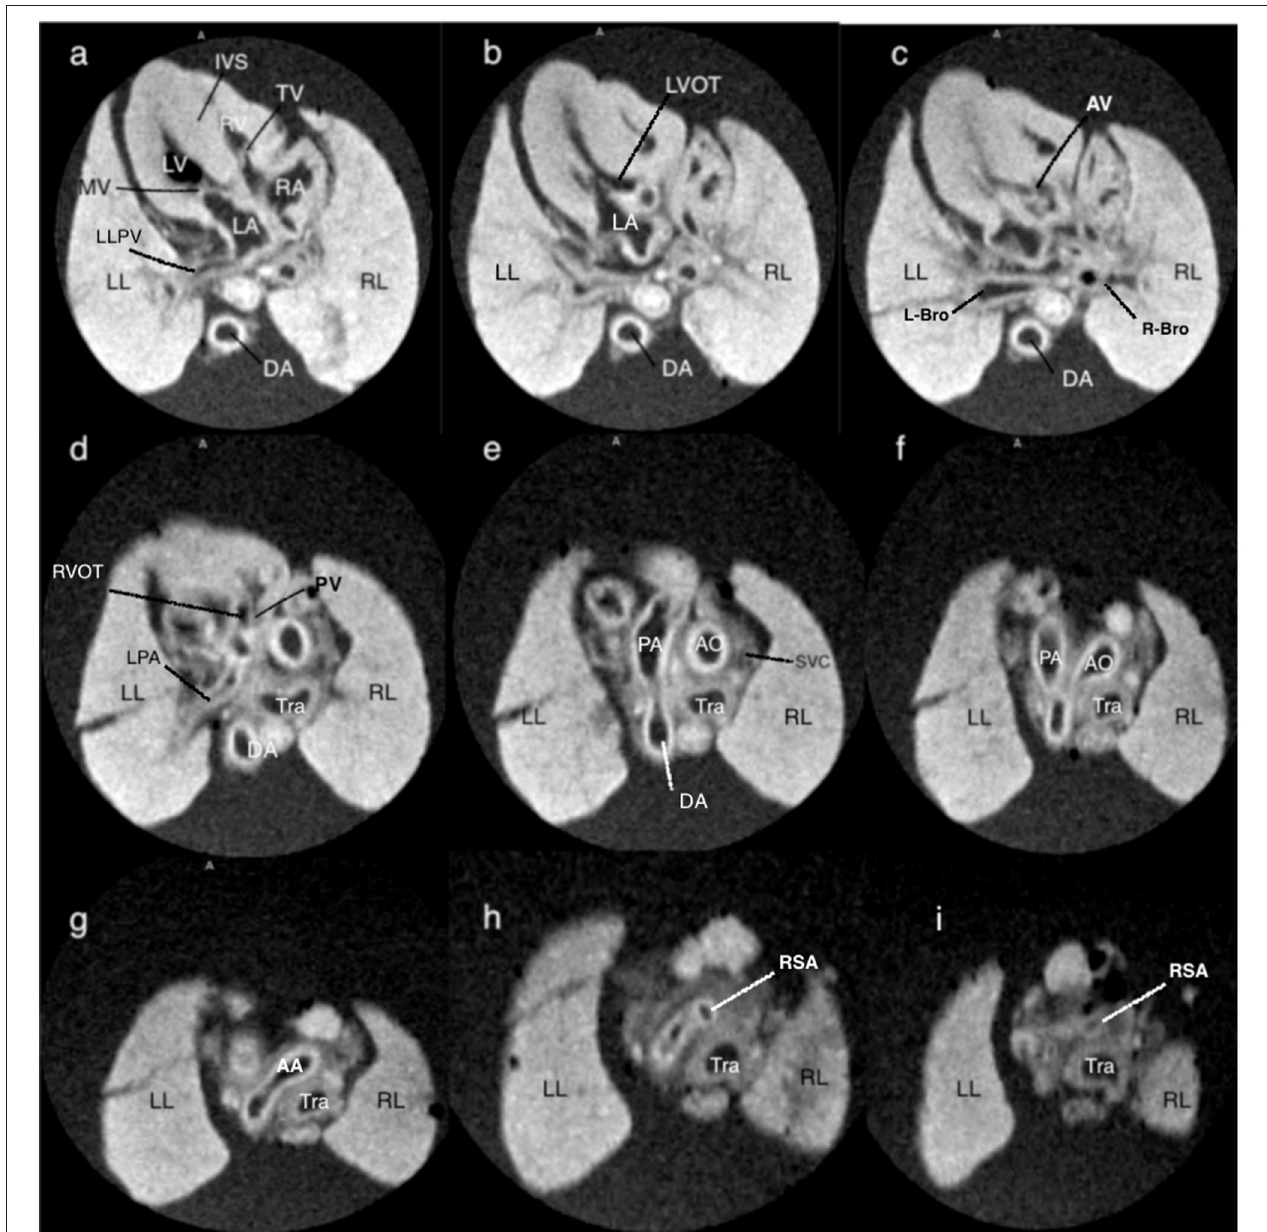
FIGURE 2 | T1-weighted magnetic resonance consecutive images at 9.4T of a fetus with normal cardiac anatomy, following termination of pregnancy at 13 + 1 weeks of gestation. (a) at the level of four-chamber view, showing a normal situs of the heart surrounded by the lungs, and a normal four-chamber view. (b,c) at the level of the left outflow tract showing the medial aortic wall was continuous with the ventricular septum and aortic valve. (d) at the level of the right outflow tract with a pulmonary artery that originates from the right ventricle with the clear bifurcation of the main pulmonary artery and left pulmonary artery. (e) at the level of the three-vessel view, the main pulmonary artery, ascending aorta, and superior vena cava are arranged in a straight line that extends from the left anterior to the right posterior. (f) at the level of the three-vessel and trachea view showing the transverse aortic arch and isthmus merge into the descending aorta, as does the pulmonary trunk and ductus arteriosus, creating a V-shaped configuration. (g–i) showing the right subclavian artery that branches off the aorta. LA, left atrium; LV, left ventricle; RA, right atrium; RV, right ventricle; RL, right lung; LL, left lung; TV, tricuspid valve; MV, mitral valve; LLPA, left lung pulmonary vein; DA, descending thoracic aorta; IVS, interventricular septum; LVOT, left ventricle outflow tract; AV, aortic valve; L-Bro, left bronchus; R-Bro, right bronchus; LPA, left pulmonary vein; RVOT, right ventricle outflow tract; Tra, trachea; PA, pulmonary artery; AO, aorta; AA, aortic arch; SVC, superior vena cava; RSA, right subclavian artery.